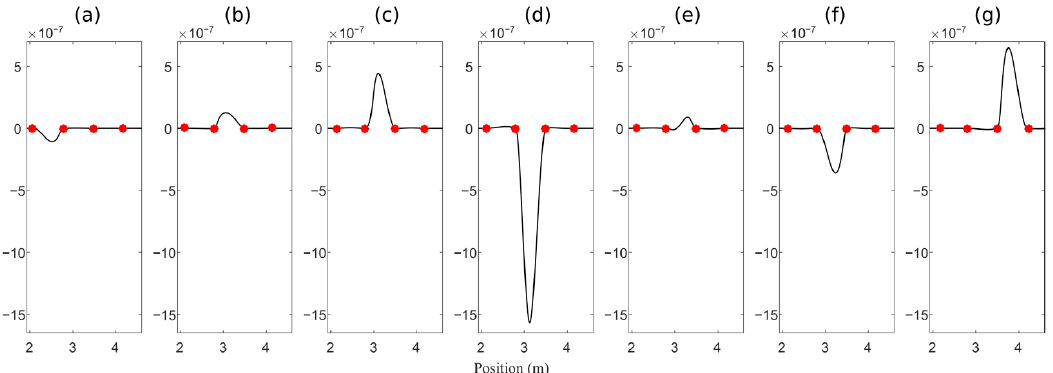
Figure 11. Evolution of the deflection of the rail in the lateral direction. The red dots are the sleepers D4 and D7. ( a ) Passage between sleepers D4 and D5, ( b – f ) passage between sleepers D5 and D6 and ( g ) passage between sleepers D6 and D7.